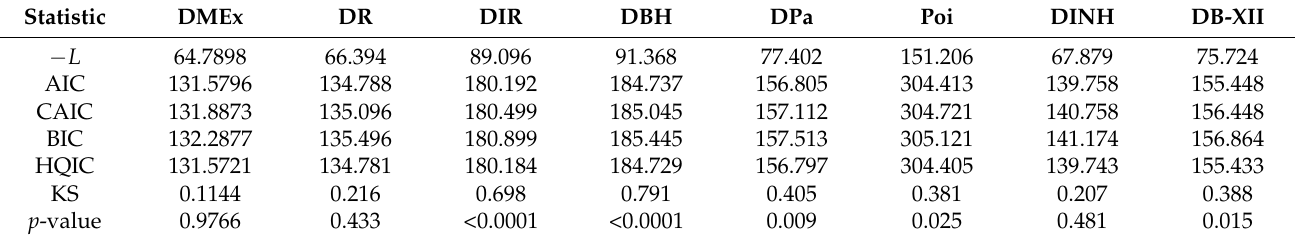
Table 7. The GOF test for EC data. Table 7 . The GOF test for EC data.